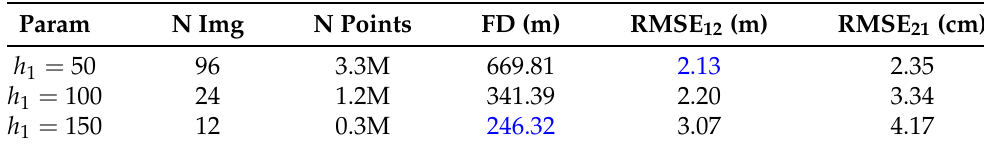
Table 4. Quality metrics for different altitudes for simple and double grid options with a frontal and lateral overlap of 90% and 80%, respectively. Blue values represent the best result for each configura- tion.